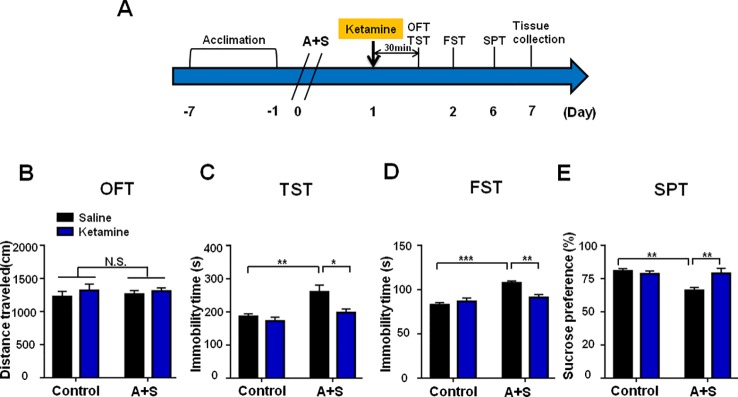
Ketamine pretreatment alleviated POD-like symptoms. (A) The schedule of treatment and behavioral tests. Ketamine (10mg/kg, i.p.) was administered on day 1 after A+S, behavioral tests, including OFT, TST, FST, and SPT were performed on day 1, 2, and 5 after A+S, respectively. (B) OFT [Group: F
(1,
28) = 0.032, P = 0.8589; Ketamine: F
(1,
28) = 0.9528, P = 0.3374; interaction: F
(1,
28) = 0.09904, P = 0.7553] in control and A+S groups. (C) TST [Group: F
(1,
28) = 13.51, P = 0.001; Ketamine: F
(1,
28) = 7.752, P < 0.01; interaction: F
(1,
28) = 3.116, P = 0.0884] was measured in control and A+S groups. (D) FST [Group: F
(1,
28) = 4.124, P = 0.0519; Ketamine: F
(1,
28) = 21.47, P < 0.01; interaction: F
(1,
28) = 10.33, P < 0.01] was measured in control and A+S groups. (E) SPT [Group: F
(1,
28) = 4.227, P < 0.05; Ketamine: F
(1,
28) = 7.737, P < 0.01; interaction: F
(1,
28) = 8.566, P < 0.01] was measured in control and A+S groups. Data are shown as mean ± SEM (n = 8). *P < 0.05, **P < 0.01, ***P < 0.001. A+S, anesthesia and surgery; FST, forced swimming test; N.S., not significant; OFT, open field test; POD, postoperative depression; SPT, sucrose preference test; TST, tail suspension test.